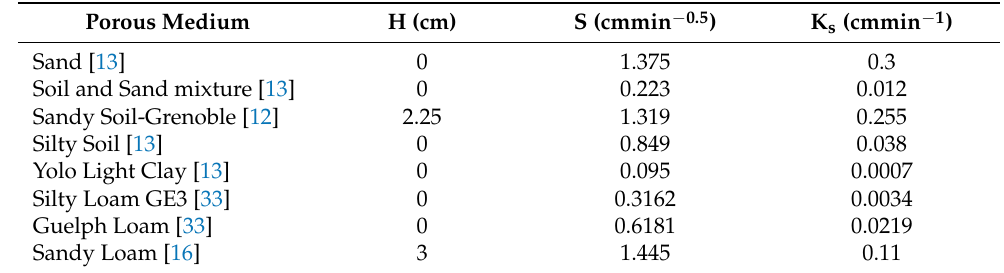
Table 1. Hydraulic properties of porous media studied (saturated hydraulic conductivity (K s ) and soil sorptivity (S)) and the corresponding applied ponding depths